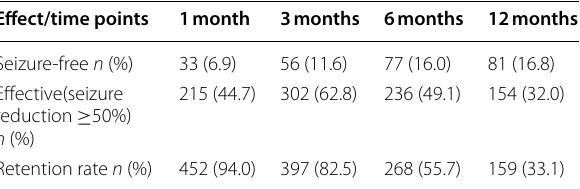
Table 1 Effectiveness and retention rate of KD in 481